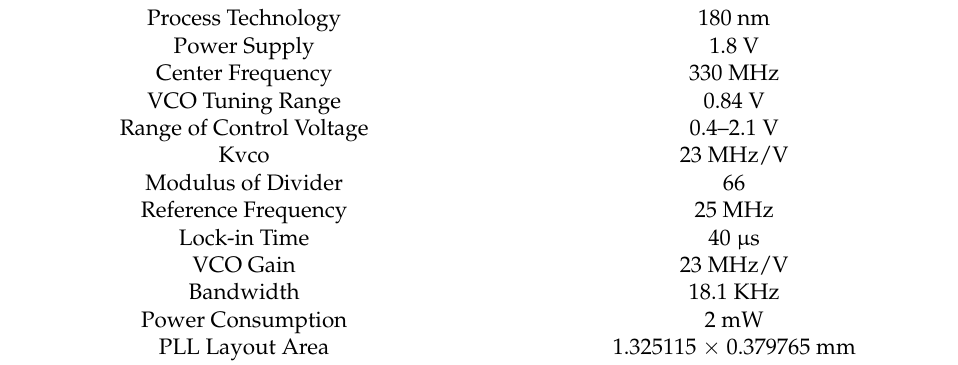
Table 2. Summary of PLL